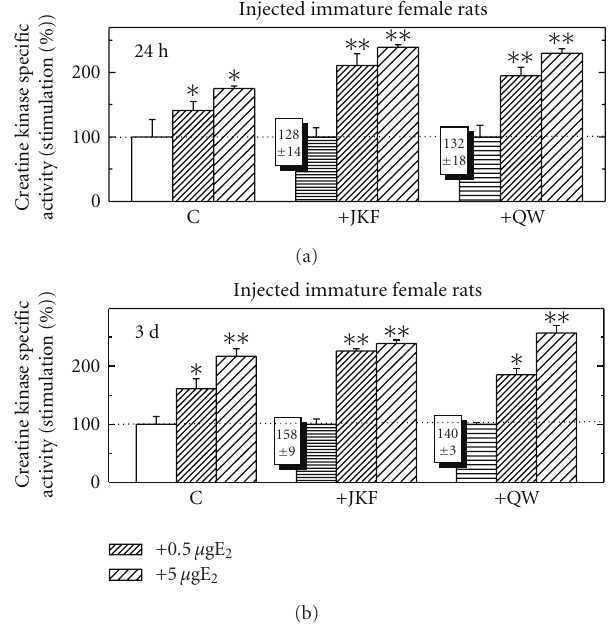
for 24hours (a) or for 3 days (b) on CK activity in Pi from immature female rats compared to the stimulation of E 2 at 0.5 μ g/rat or 5 μ g/rat and to the combination of the vitamin D analogs with E 2 . Treatments were as described in Section 2. Results are expressed as the ratios between the specific activities of CK in hormone- treated and vehicle-injected control animals. The basal activity of CK in was 0 . 86 + 0 . 14 μ mol/min/mg protein after 24hours and 0 . 92 + 0 . 18 μ mol/min/mg protein after 3 days, n = 5. ∗ P < . 05, ∗∗ P < . 01 in the di ff erence compared to